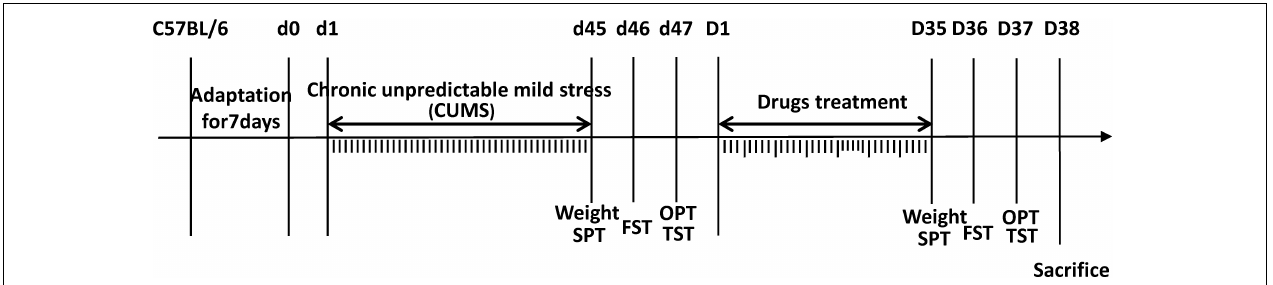
FIGURE 1 | Schematic diagram of the experimental procedure, as described in the Section “Materials and Methods.” The behavioral tests, including the sucrose preference test, forced swimming test, open-field test, and tail suspension test, were performed after chronic unpredictable mild stress (CUMS) and before sacrifice. Mice were subjected to different kinds of mild stressors for 45 days preceding drug treatment to induce CUMS. LMW and HMW FGF-2 treatment were administered every other day after CUMS and continued for 5 weeks. All mice were sacrificed following the behavioral tests. d1–d45 indicates the days animals subjected to CUMS; D1–D35 indicates the days animals received the FGF-2